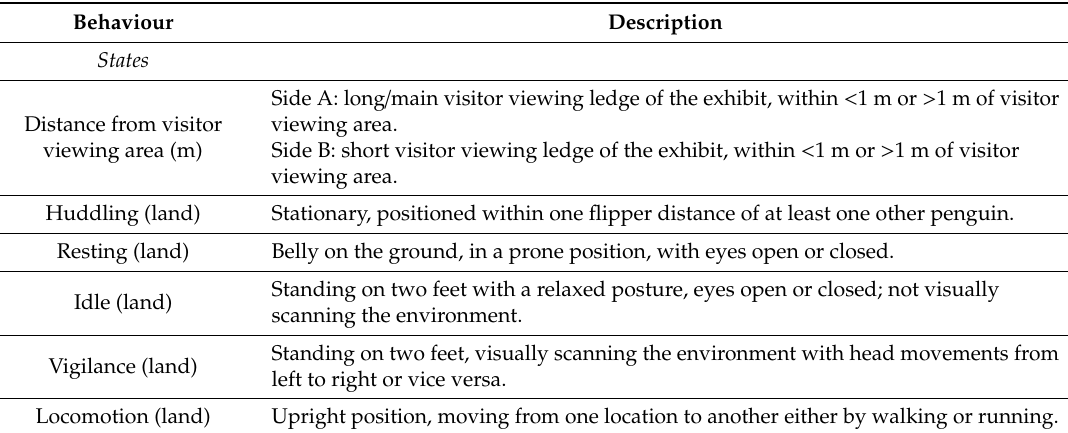
Figure 4. The areas studied, captured by the cameras: ( a ) Area 1—captured the main pool corner of the exhibit where penguins were clearly visible to visitors in this area (the red line indicates where Area 1 ended for observations due to overlap between the cameras for Area 1 and 2) ( b ) Area 2—captured the main length of the pool (penguins in this area were clearly visible to visitors), ( c ) Area 3—captured the pier and a section of the pool (penguins were clearly visible to visitors in this area) and ( d ) Area 4—captured the land area of the exhibit (penguins in this area were either not visible to visitors or partially obstructed by exhibit features including vegetation, wooden barriers, nest boxes). Table 1. Ethogram of penguin behaviour.